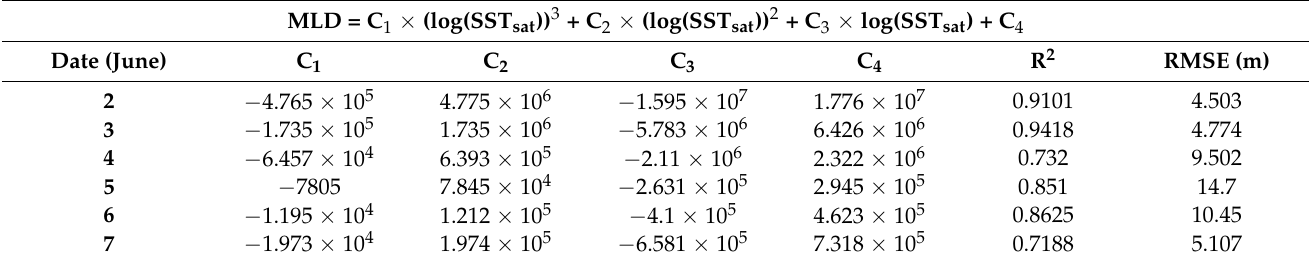
Table 1. Coefficients and statistical characteristics of fitted curves representing the SST-MLD